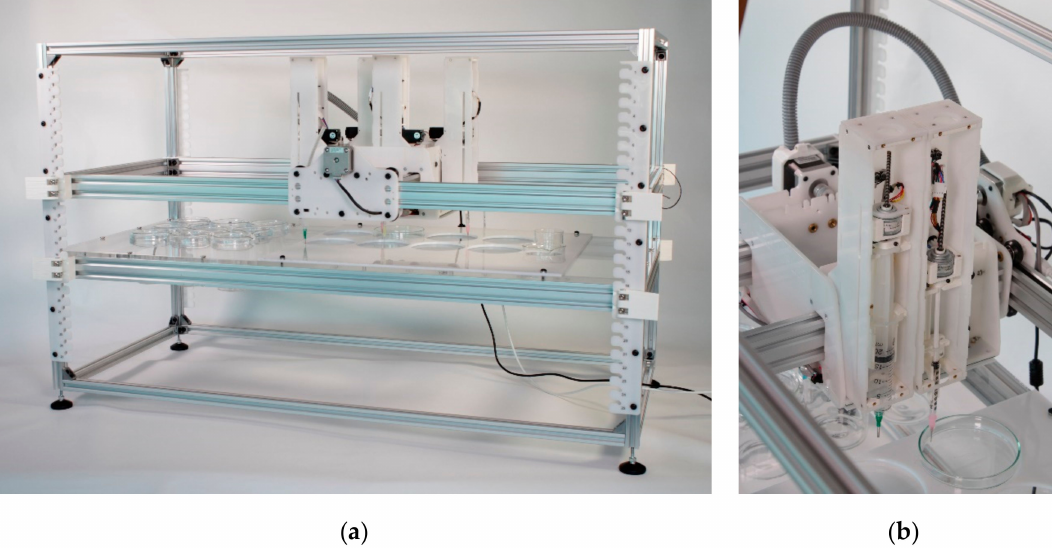
Figure 1. The EvoBot liquid handling robot. ( a ) The robot is prepared to perform experiments with Petri dishes and reagents on the experimental layer and four modules in the head; ( b ) A close-up of the movable head equipped with two di ff erent syringe modules (5 m and 1 mL